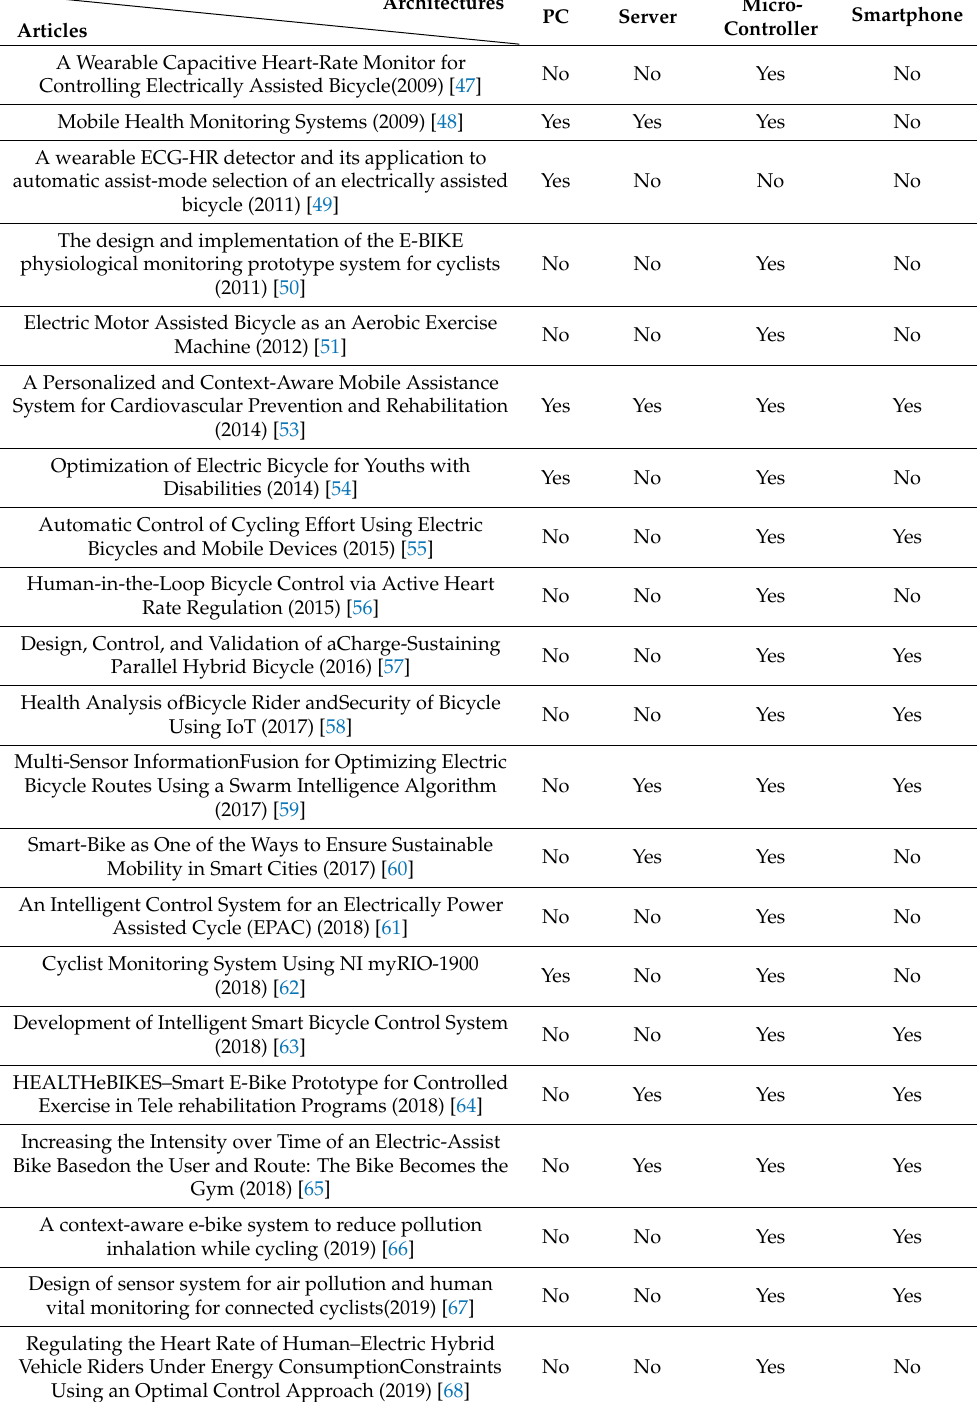
Architectures PC Server